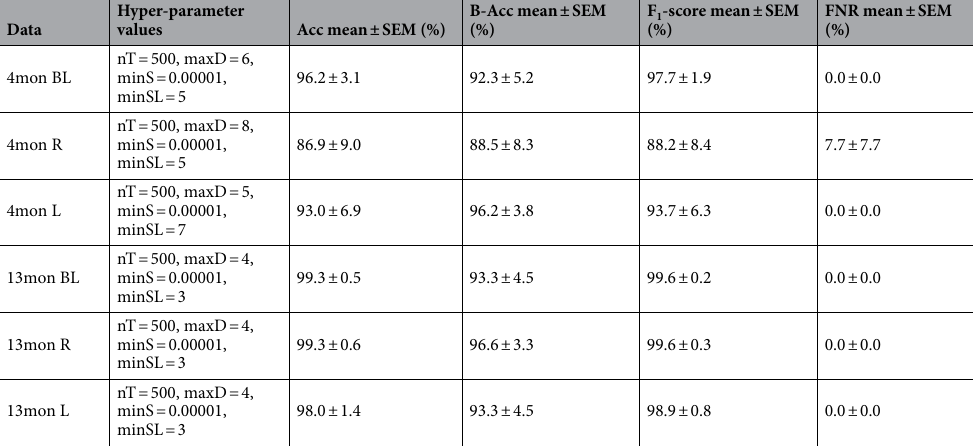
Table 2. Evaluation of different classification algorithms. Mean and standard error of the mean (SEM) of all leave-one-out cross validation classification accuracies (Acc), balanced accuracies (B-Acc), F1-Score, and False Negative Rate (FNR). Data were derived from the bilateral (BL), right-side-only (R), left-side-only (L), within each 4-months-only (4mon), and 13-month-only (13mon) datasets. Definition of the RF model hyper- parameters: RF-nT: number of trees, maxD: minimum depth of the tree, minS: minimum samples required to split an internal node,